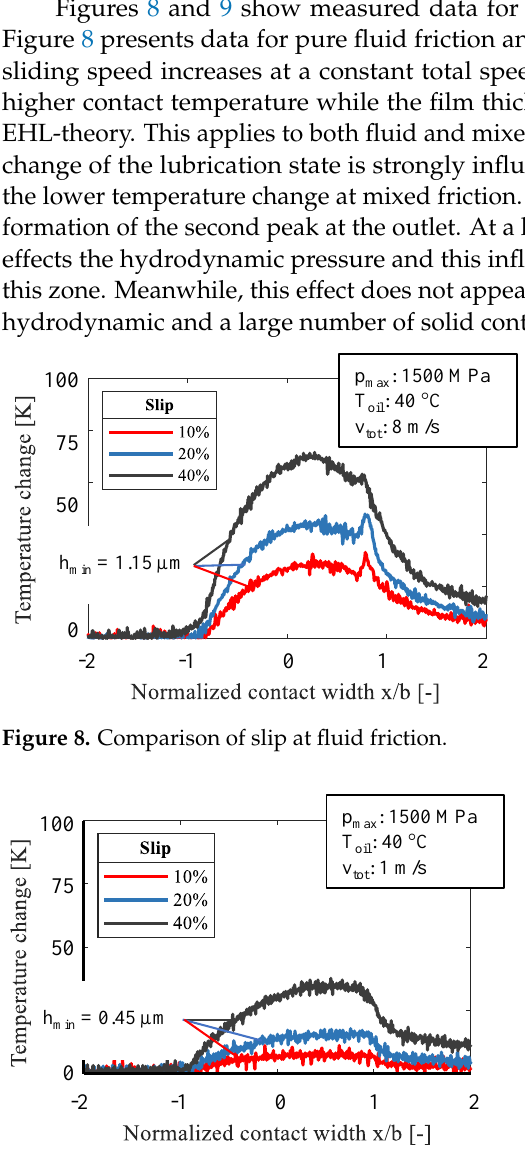
Figure 7. Influence of total velocity on temperature change.